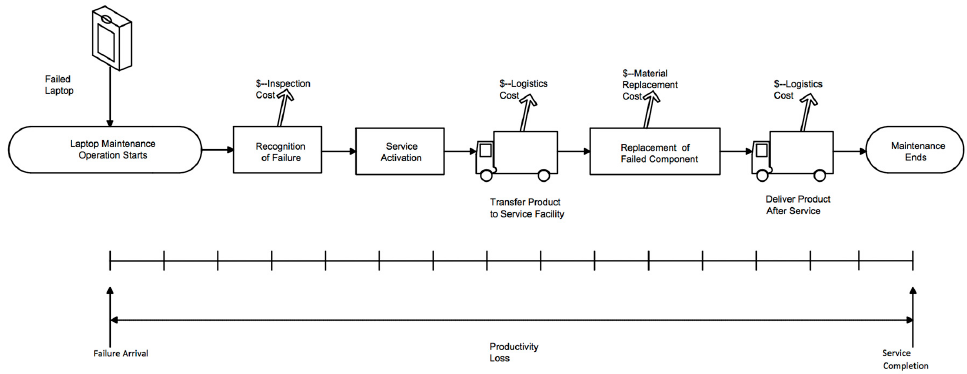
Figure 3. Maintenance operations of RL systems.